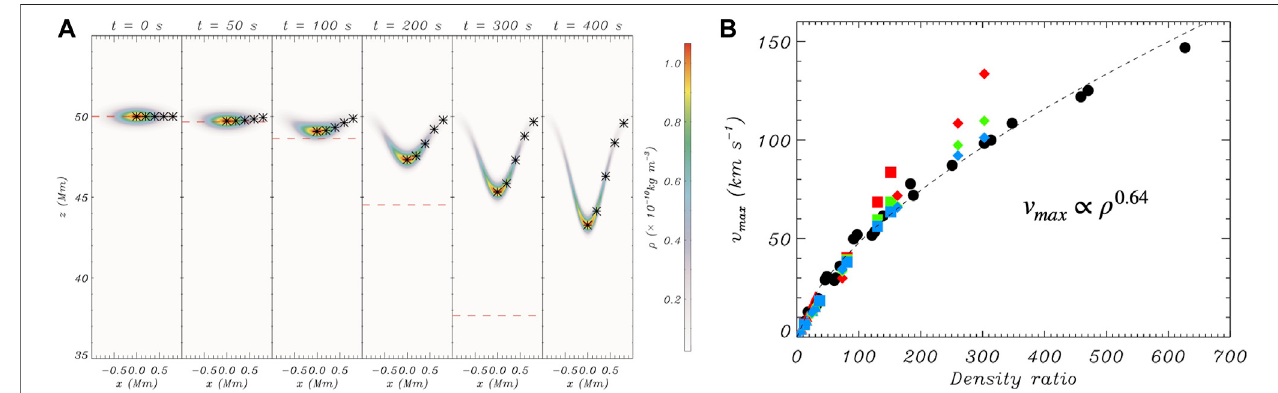
FIGURE 11 | Simulated downward motion of a rain-like clump. (A) Snapshots of density at different times of a clump falling under the action of gravity in a homogeneous atmosphere in a 2.5D MHD setup. The dashed red line denotes the position that would correspond to a free-falling object. (B) the maximum velocity achieved by the clump plotted against the density ratio Θ between the clump and the external environment. Different colours denote simulations with different magnetic fi elds. Red, green and blue colour correspond to B 0 = 5, 10 and 20 G, respectively. Triangles, squares and diamonds denote different maximum clump densities, with 1, 5, 10 × 10 – 10 kg m − 3 , respectively. The dashed curve shows the fi t v max = 2.56 Θ 0.64 , with Θ the density ratio (taken from Figures 1, 3 in Martínez-Gómez et al., 2020, reproduced with permission ©